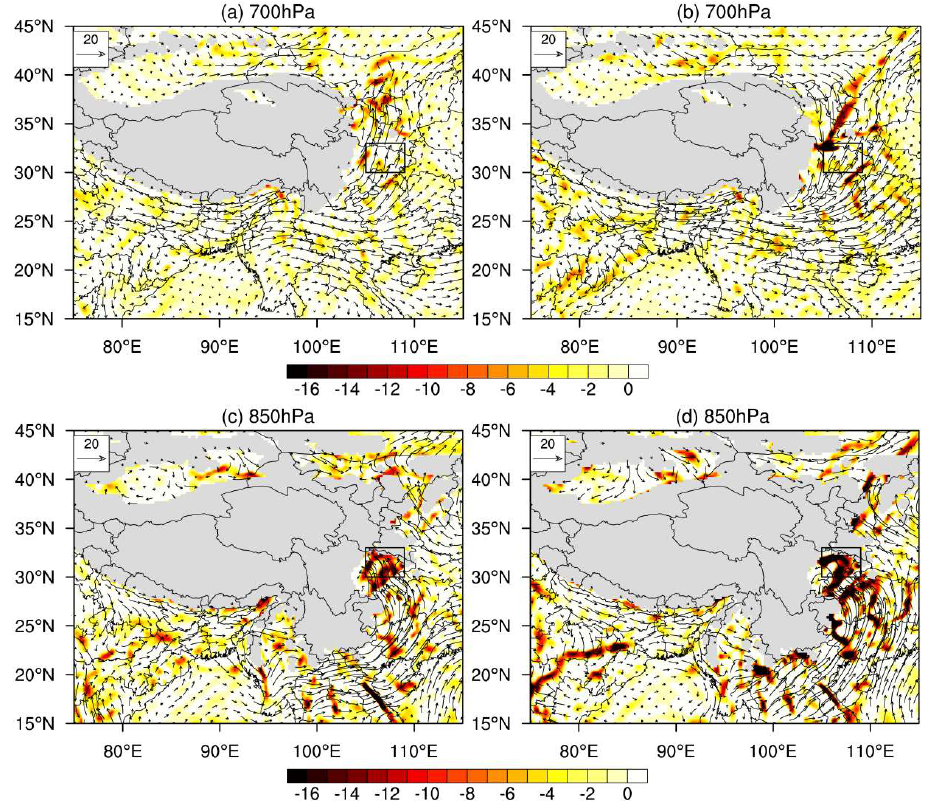
Figure 6. Distributions of moisture flux (vectors, g · s − 1 · hPa − 1 · cm − 1 ) and moisture flux divergence (b, 10 − 5 g · s − 1 · hPa − 1 · cm − 2 ) at 2200 UTC 1 May ( a , c ) and 1600 UTC 2 May ( b , d ). Black rectangles represent the northeast of the Sichuan basin.